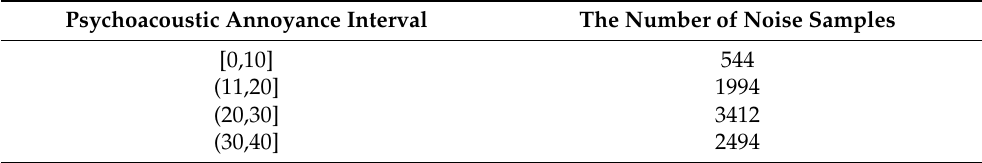
Table 2. The distribution of psychoacoustic annoyance data. Calculated by the Zwicker method [21]; in this paper, the range of psychoacoustic annoyance is